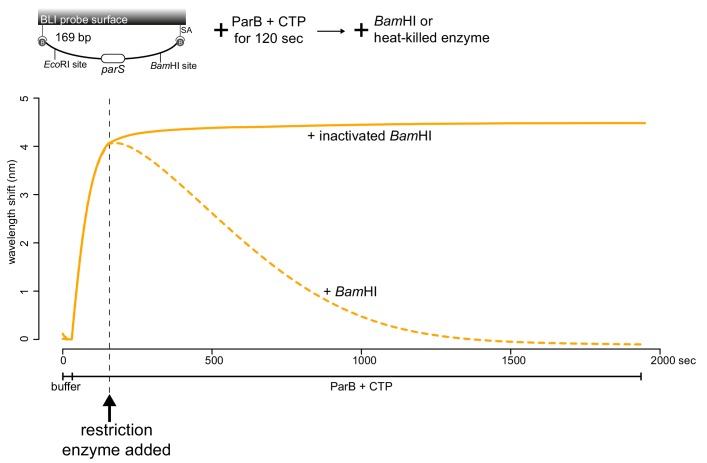
Linearization of a closed DNA substrate by BamHI liberates pre-bound ParB from DNA.
BamHI was added after 1 μM Caulobacter ParB-His6 + 1 mM CTP and a 169 bp dual biotin-labeled parS DNA were preincubated together for 120 s. As a negative control, heat-inactivated BamHI was added instead. Mg2+ was included in all buffers for this experiment. A schematic of the DNA substrate is shown above the sensorgram.Figure 3—figure supplement 2—source data 1.Data used to generate Figure 3—figure supplement 2.